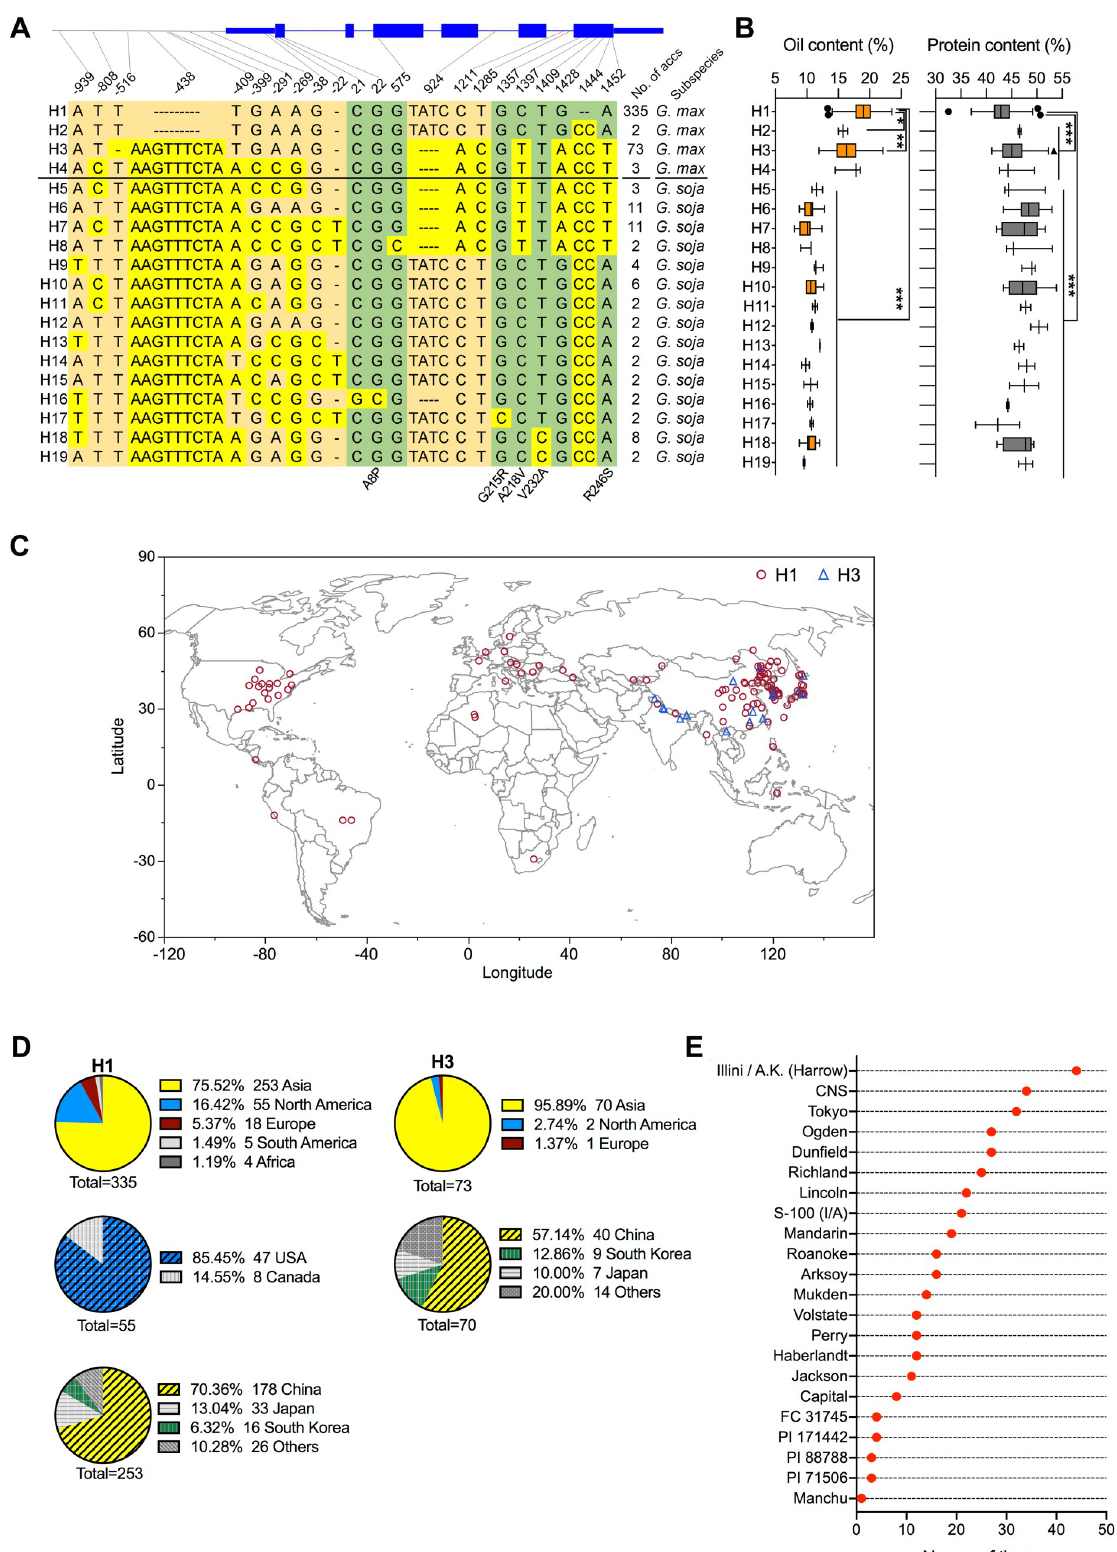
Fig 4. Analyses of haplotype distribution worldwide and the use frequency of H1 in US soybean breeding. ( A ) A schematic diagram shows the distribution of all DNA variants identified in GmSWEET39 and its putative 1,000-bp promoter region. 19 haplotypes (H)